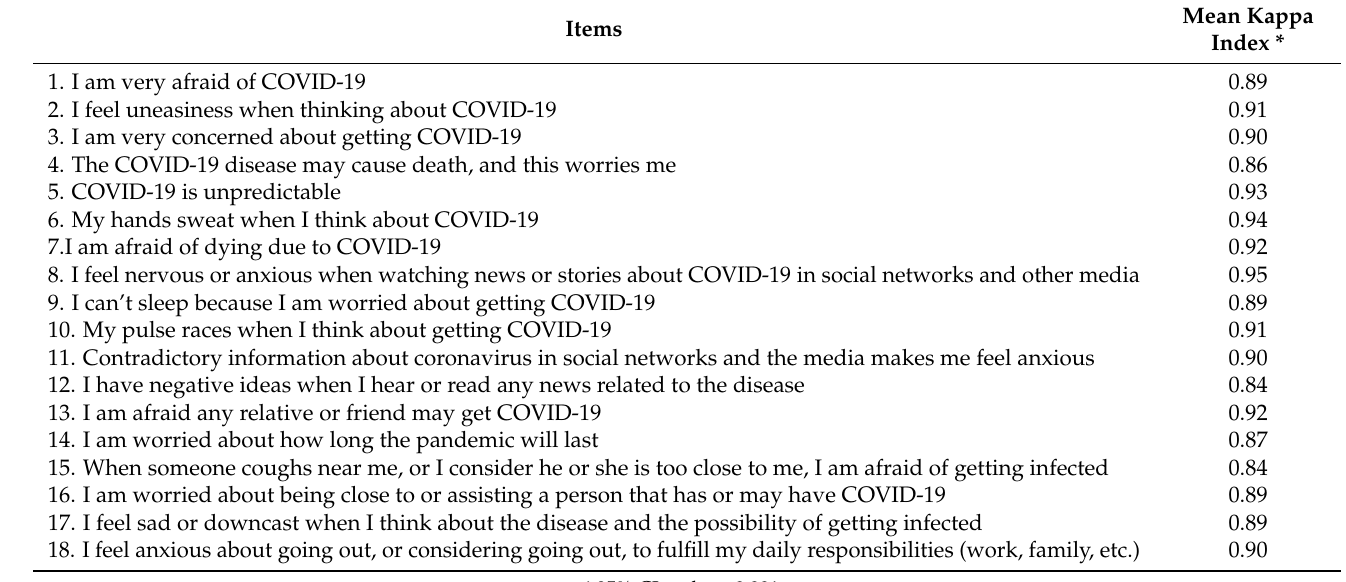
Table 1. Mean Kappa coefficient by the designed questionnaire items. COVID-19; coronavirus disease 2019. Items